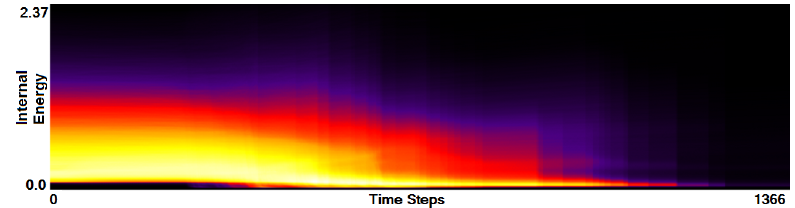
Figure 9. Function plot aggregated from all 45 astrophysical multi-run simulations without synchronization. General structure cannot be recognized. Vertical discontinuities indicate ends of simulations.